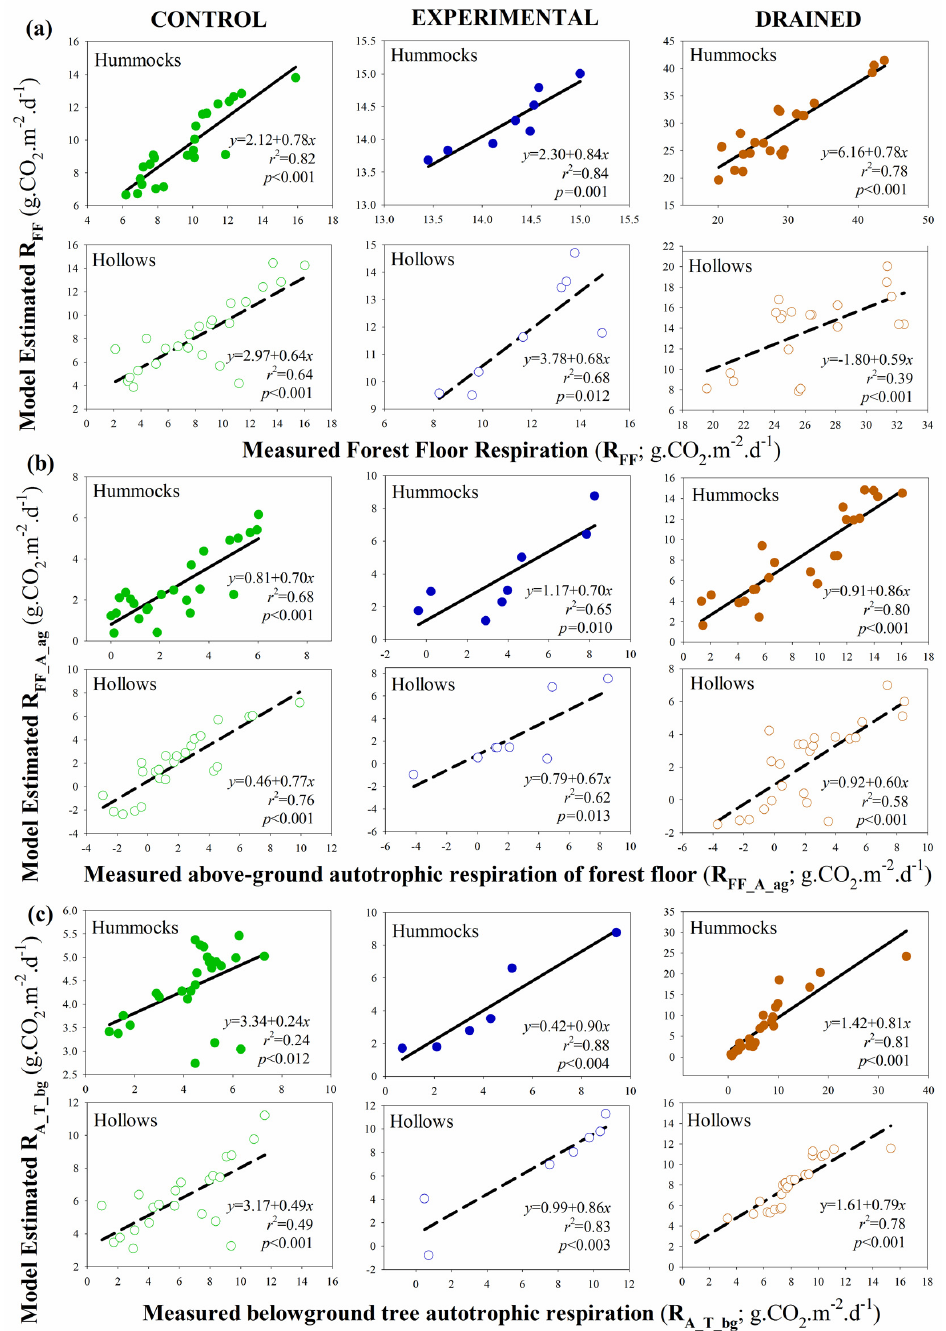
Figure A1. Goodness of fit between measured (year 2012) and model estimated values of ( a ) forest floor respiration (RFF), ( b ) aboveground autotrophic respiration of forest floor (RFF_A_ag), and ( c ) belowground autotrophic (rhizospheric) respiration of tree roots, across sites and microforms. Lines represent 1:1 fit.